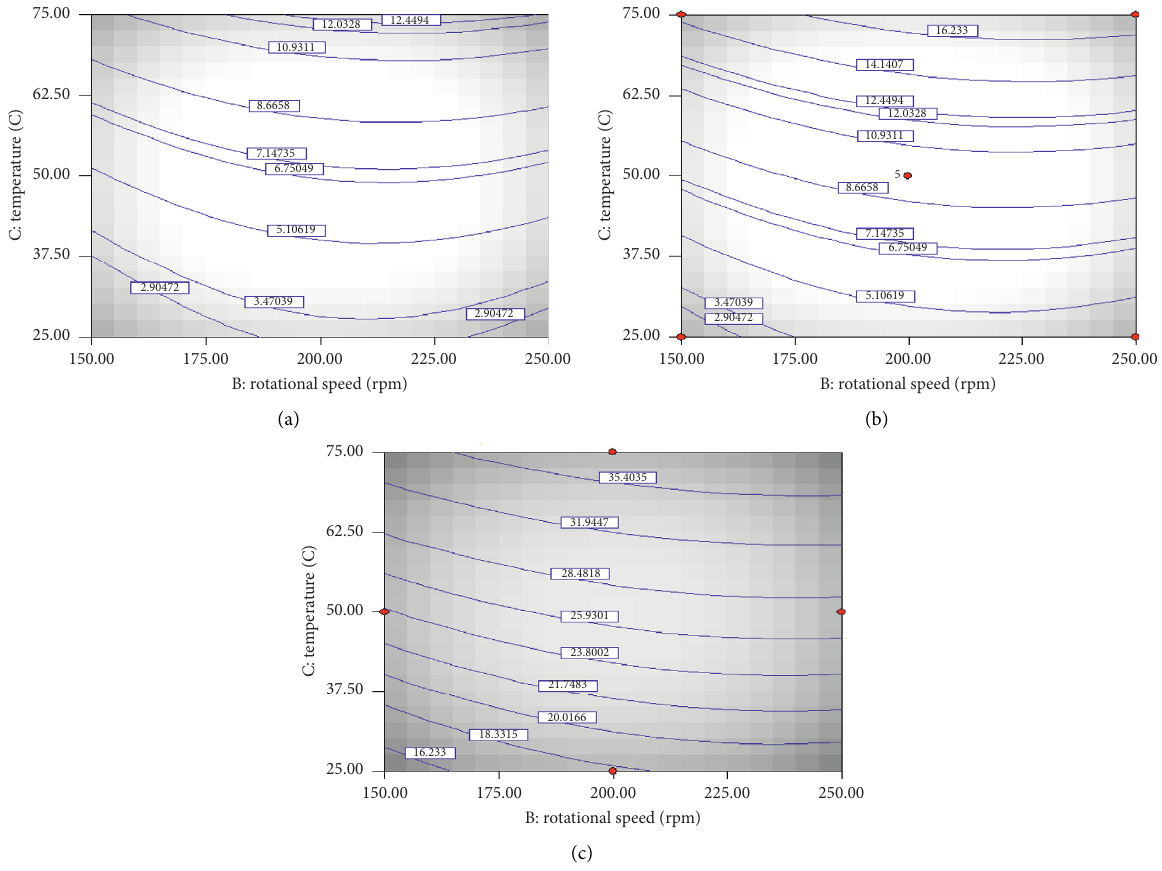
Figure 8: Contour plot of corrosion rate as a purpose of rotational speed and temperature at inhibitor loads (a) 10%, (b) 7.5%, and (c) 5% (mL/Y).